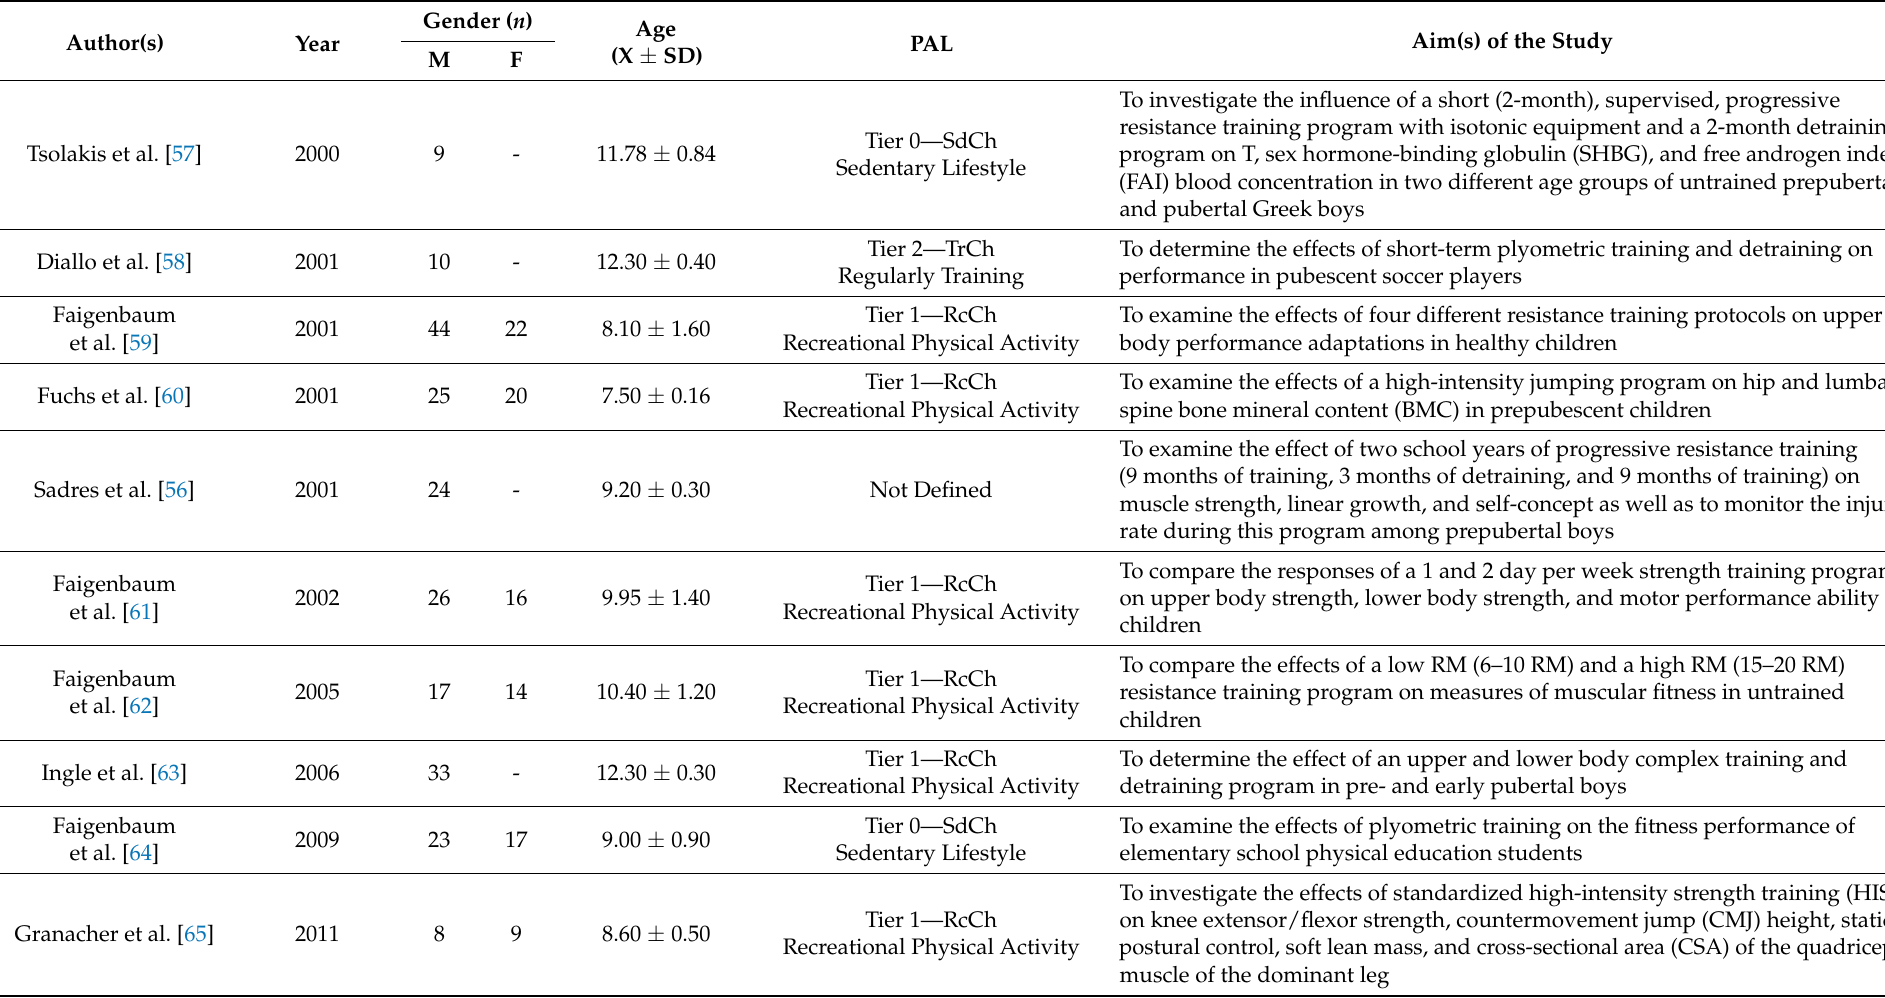
Table 2. Summary of sample characteristics (author, year, gender, age, and physical activity level (PAL)) and aim(s) of the